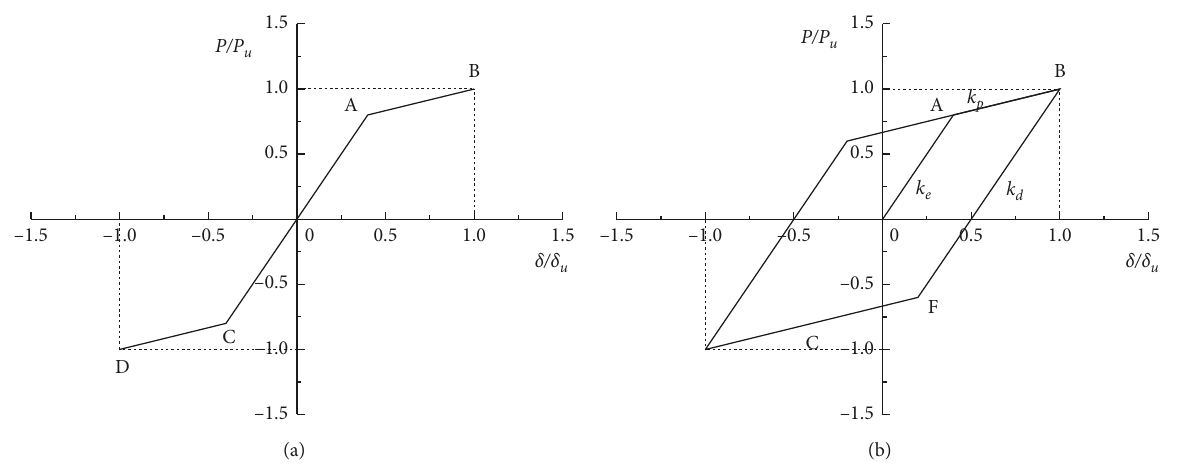
Figure 11: Loading and unloading stiffness of the